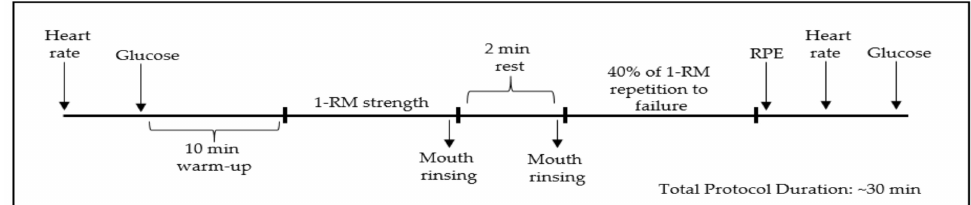
Figure 1. Schematic diagram of experimental